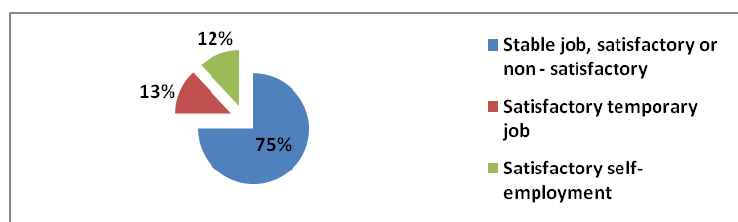
Figure 2: Transited youth by current activity